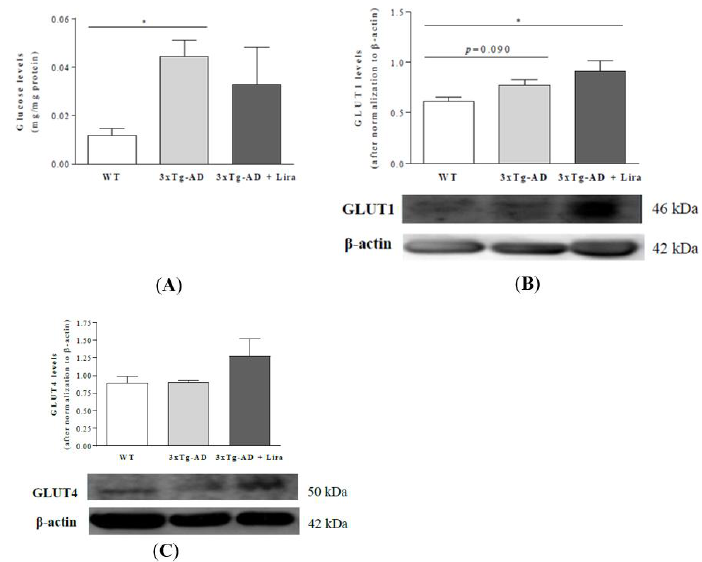
Figure 4. Effect of liraglutide on brain cortical glucose levels and transporters in mature female mice with early AD-like pathology. Brain cortical glucose ( A ), and GLUT1 ( B ) and GLUT4 protein levels ( C ) were evaluated and normalized to β-actin levels, and representative Western blotting images displayed. Data are the mean ± SE from 5–6 mice/group. Statistical significance: * p < 0.05, by the one-way ANOVA with the Fisher LSD or Games-Howell post-hoc tests for multiple comparisons.